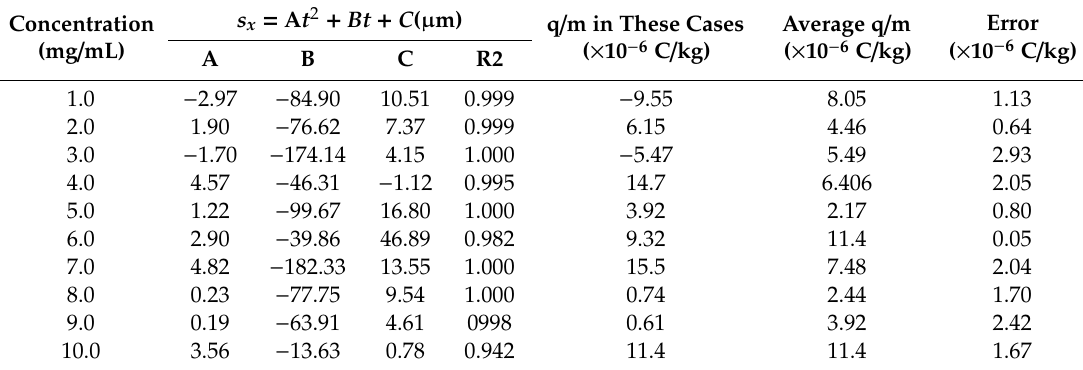
Figure 4. The X-direction displacement versus time before breakup. Table 2. The Charge-to-Mass ratio at each